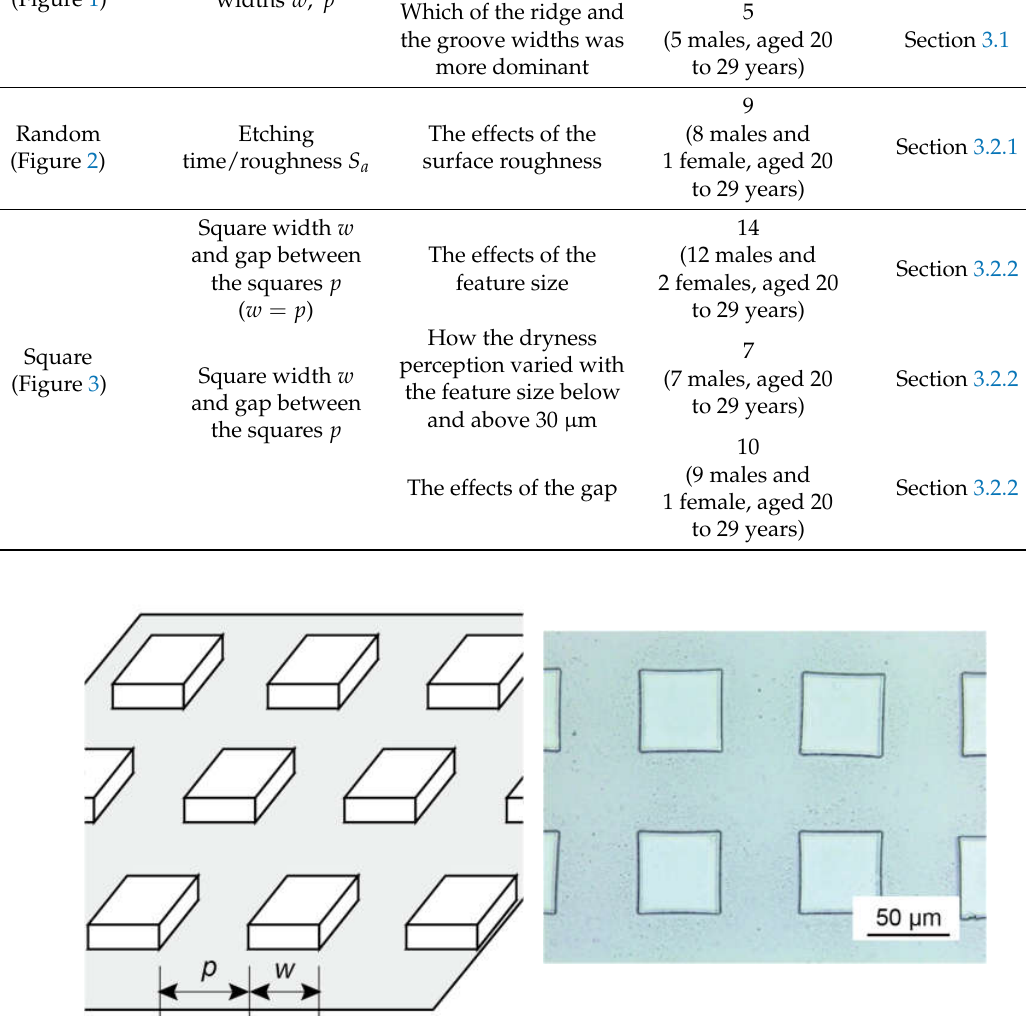
Table 1. Summary of the experiments.